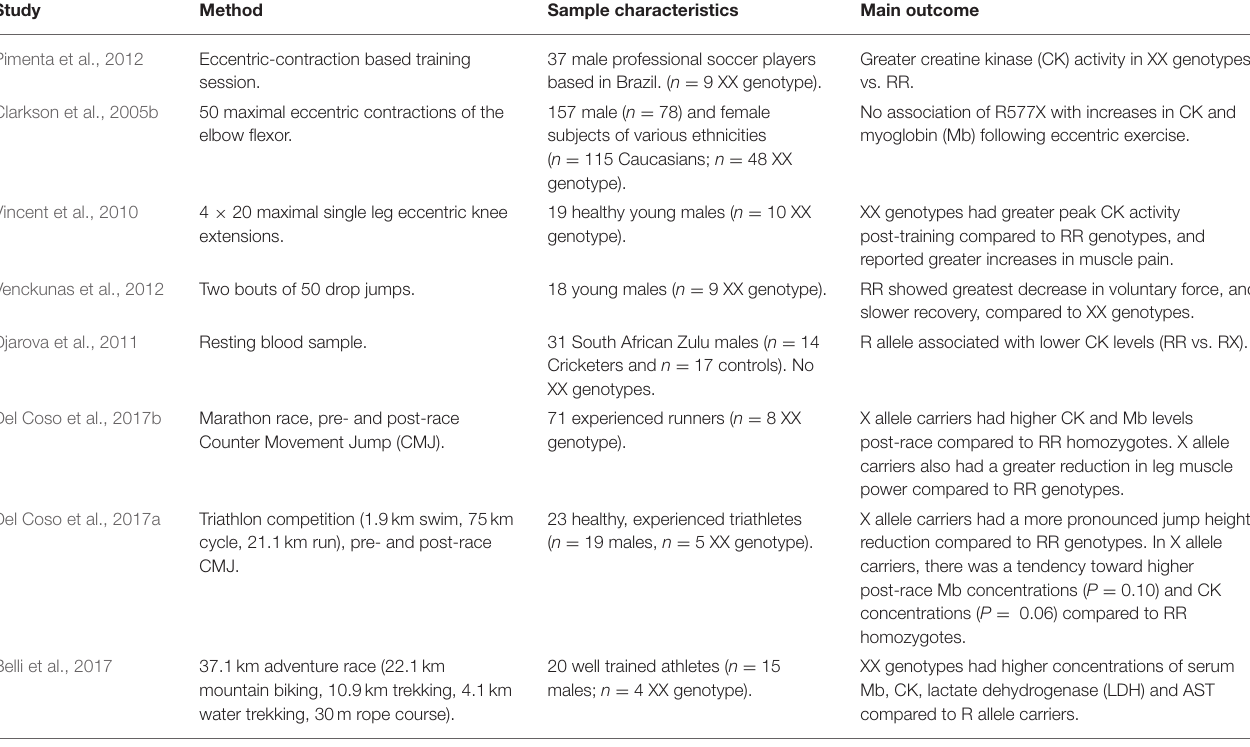
TABLE 2 | Studies examining the interaction between ACTN3 genotype and exercise recovery. Study